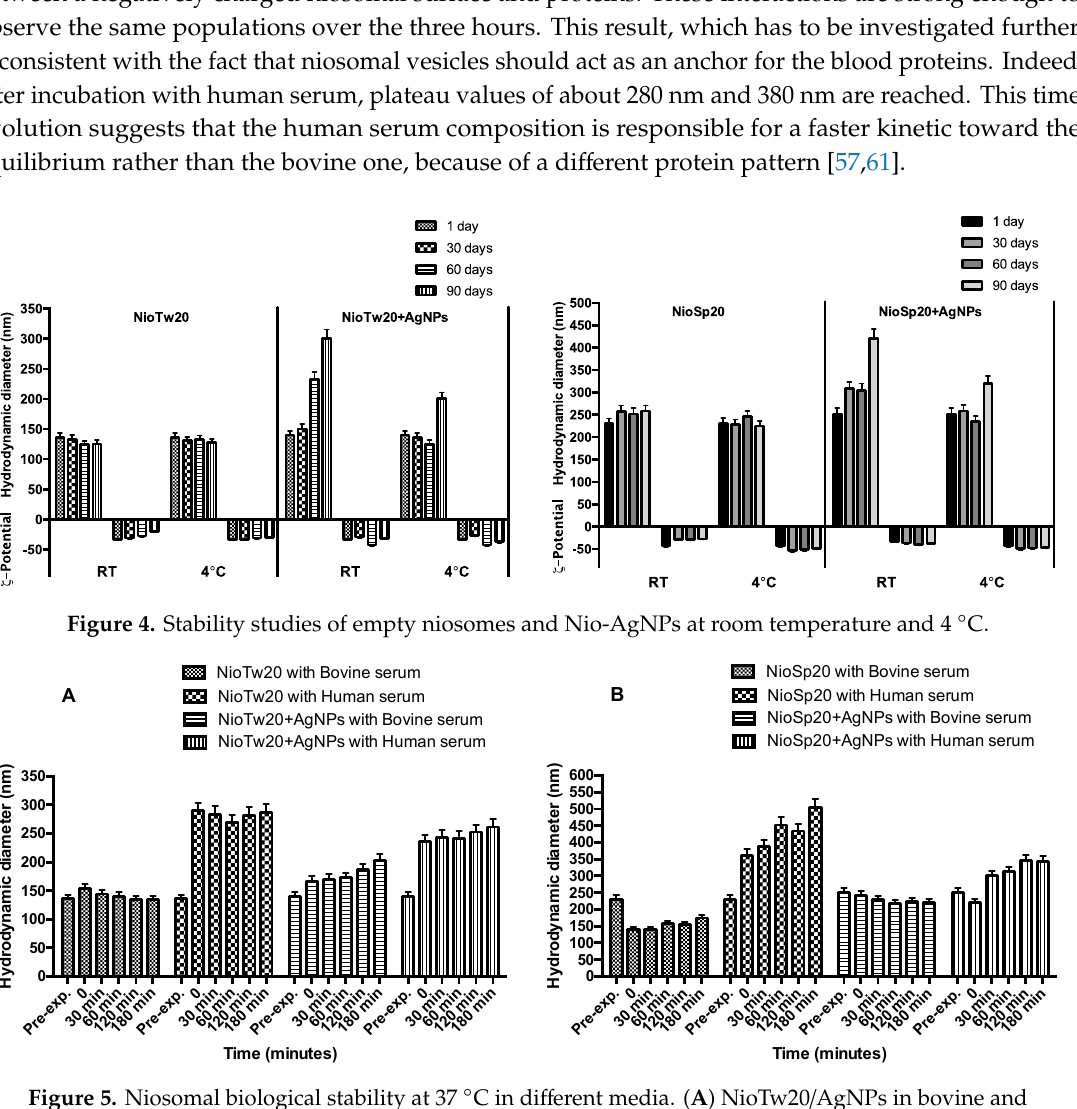
◦ C in di ff erent media. ( A ) NioTw20 / AgNPs in bovine and Figure 5. Niosomal biological stability at 37 °C in different media. ( A ) NioTw20/AgNPs in bovine Figure 5. Niosomal biological stability at 37 human serum; ( B ) NioSp20 / AgNPs in bovine and human